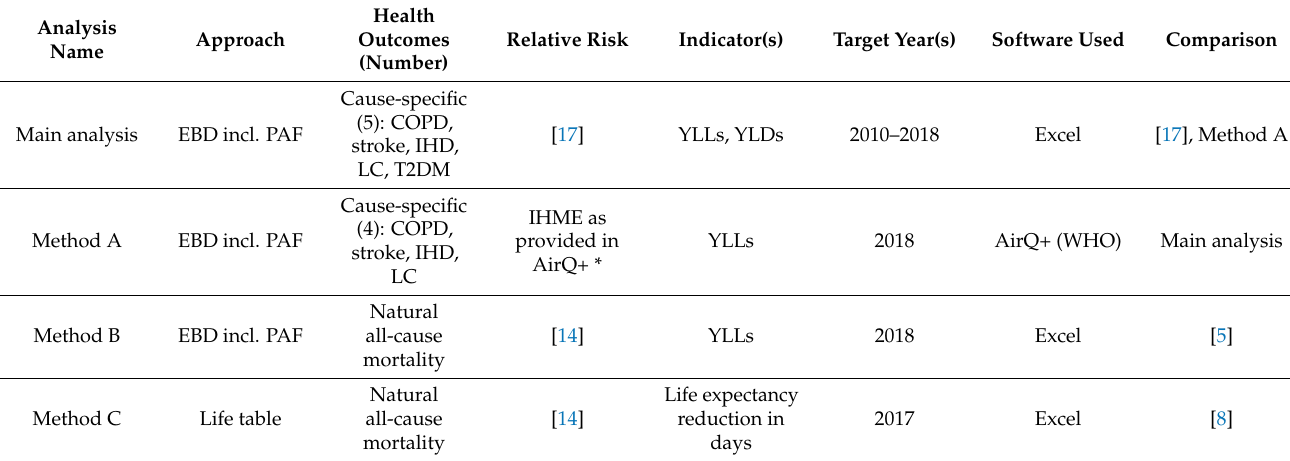
Table 1. Overview of the different analyses and approaches